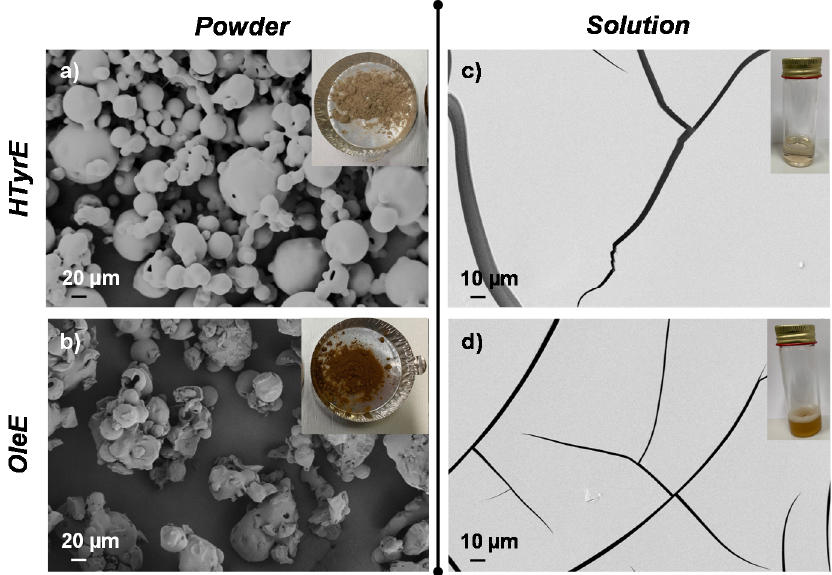
Figure 5. Visual aspect and field emission scanning electron microscopy (FESEM) images of ( a ) HTyrE and ( b ) OleE powder; ( c , d ) after dispersion in water.